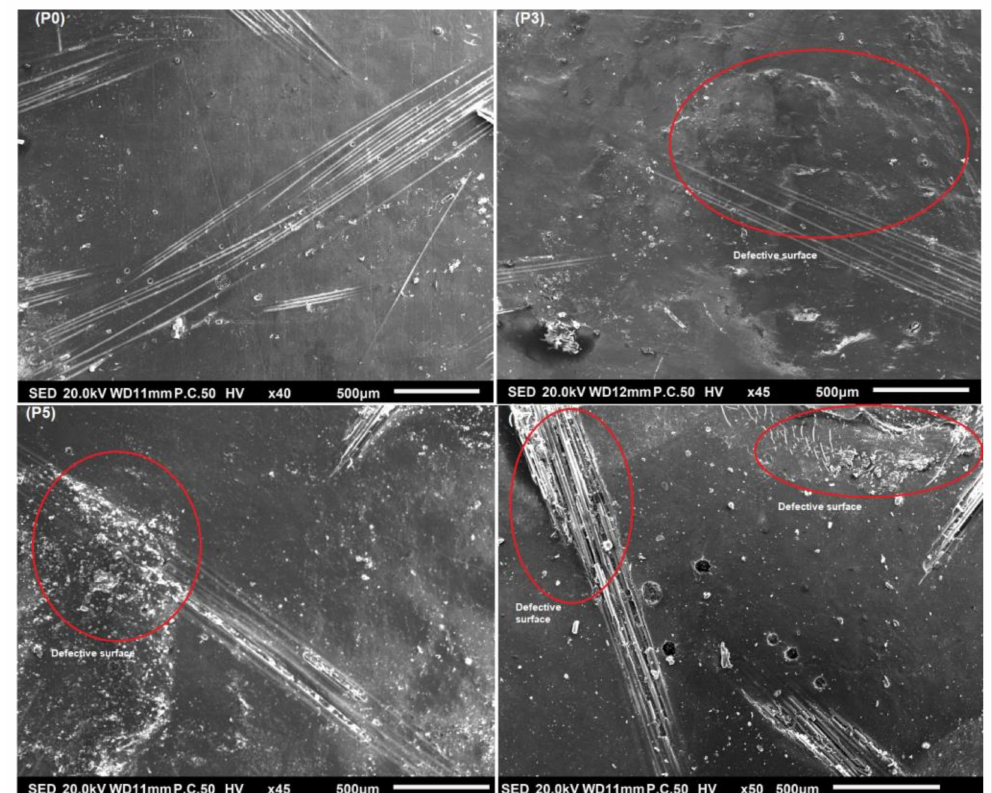
Figure 10. Morphological image of 25% GF composite at different solar irradiation periods (P0, P3, P5, P7) to show the effect of solar irradiation on the sample